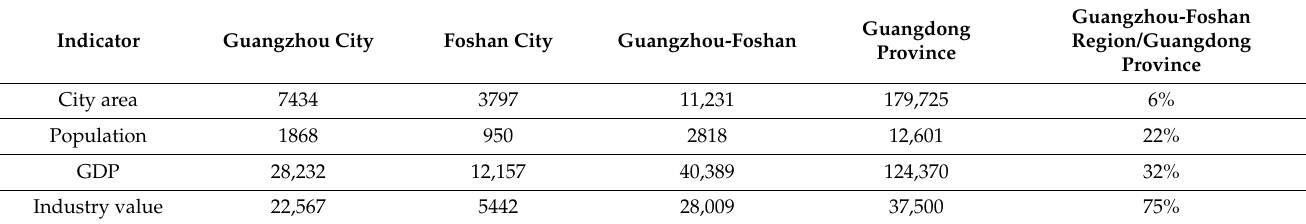
Figure 1. The study area. Source: the authors. Table 1. Economic and social development data of Guangzhou-Foshan in 2021.